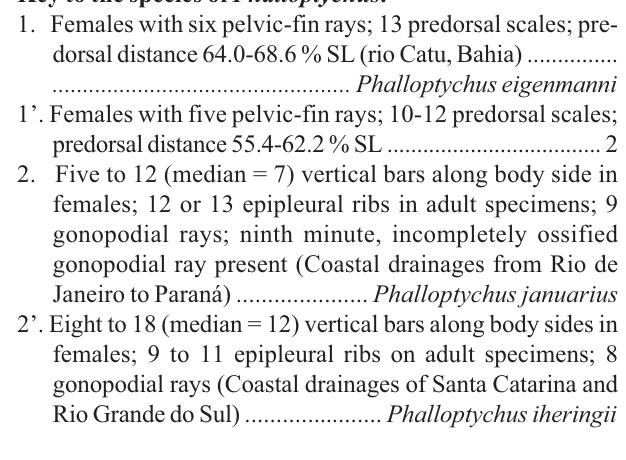
Color in alcohol. Eye greenish grey. Pupil cream. Ground color cream, darker in upper half. Scales surface border and subja- cent skin replete with many brown chromatophores, confer- ring reticulate pattern to body sides. Dark brown predorsal line. Brown chromatophores scattered through whole body, more concentrated in dorsal portion, mainly on head, snout, and ventral surface of mandible. Anus margin and urogenital area light yellow. Fins hyaline. Fin rays with two rows of brown chromatophores along each side, along extension of ray. Pale brown band on dorsal fin near its base (sometimes not easily seen). Five to 12 narrow brown bars (median = 7) along body sides of female specimens. Dark brown spot at base of R3.